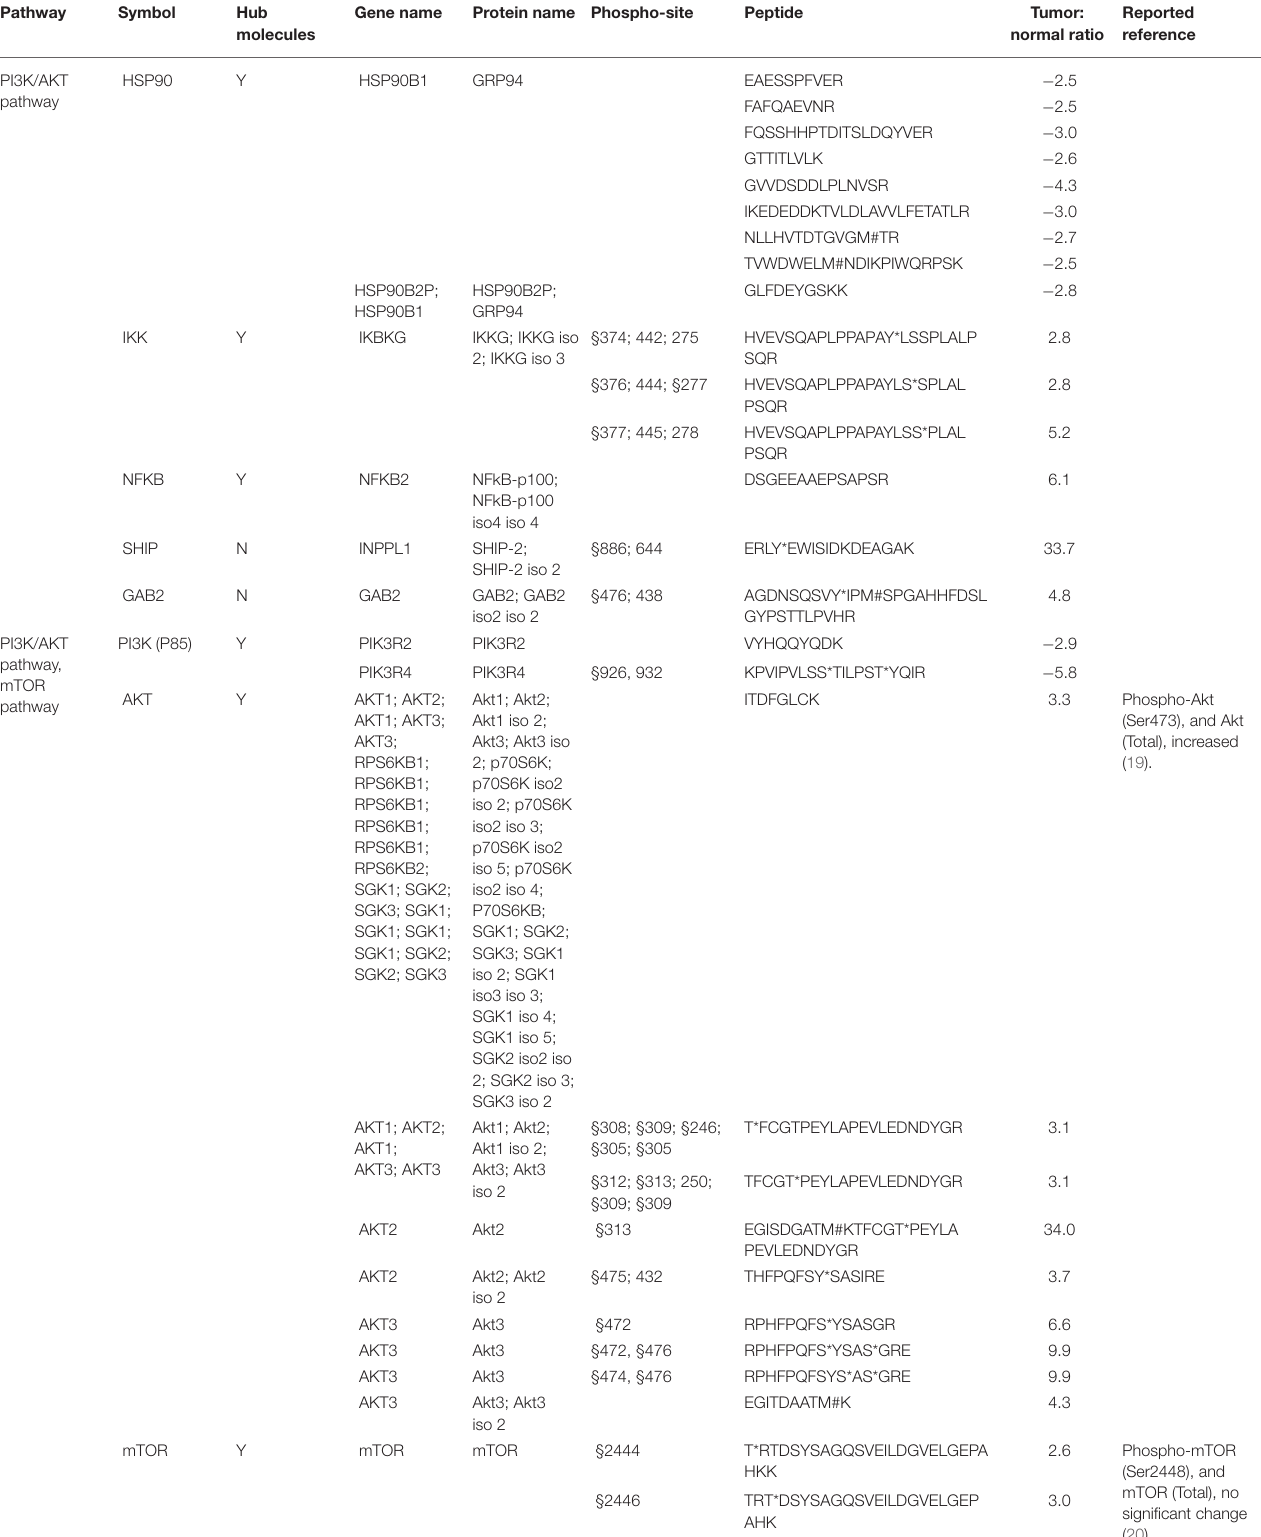
TABLE 3 | PI3K/AKT, mTOR, Wnt, and ERK/MAPK signaling pathways confirmed with PTMScan experiments and phosphorylation sites.